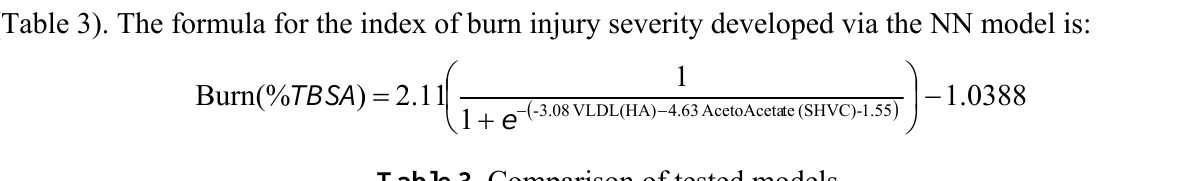
Table 3. Comparison of tested